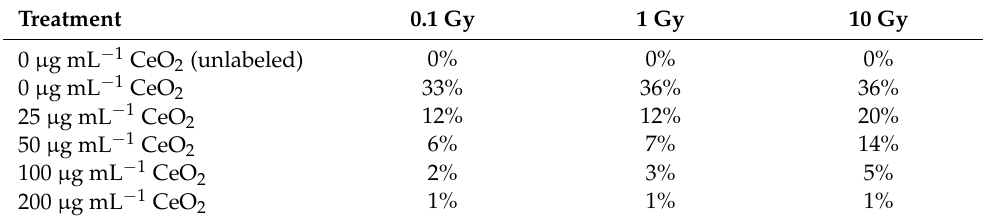
Table 5. Flow cytometry gated profiles of unlabeled or DHR123 labeled cells treated with varying concentrations of CeO 2 NP and irradiated with 0.1, 1, or 10 Gy ionizing radiation. Treatment 0.1 Gy 1 Gy